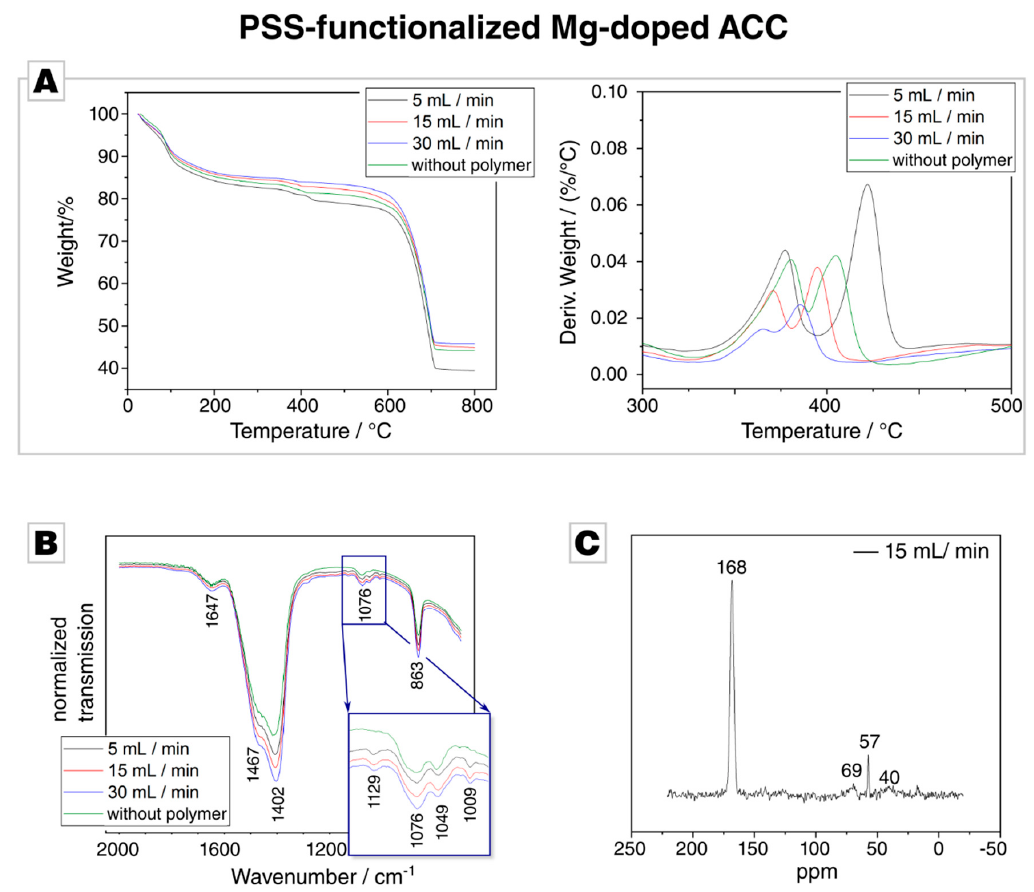
Figure 3. (A) Thermal gravimetric analysis (TGA) of ACC precipitated in the presence of PSS at flow rates. ( B ) Attenuated total reflection Fourier transform infrared (ATR-FTIR) of the PSS and different flow rates. (B) A ttenuated total reflection Fourier transform infrared ( ATR-FTIR) of the PSS